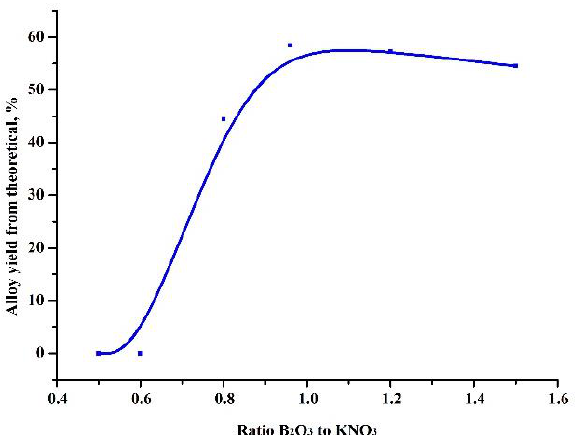
Figure 1. Dependence of the yield of the alloy on the ratio of boric anhydride and preheating additive in the charge.